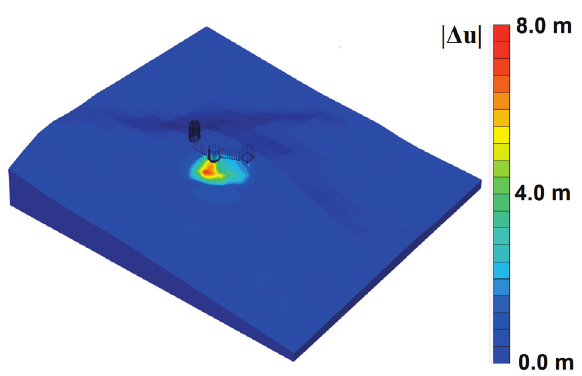
Fig. 4. The most landslide-susceptible zone in bedrock displayed through shadings of the total displacement increments (| Δ u|).